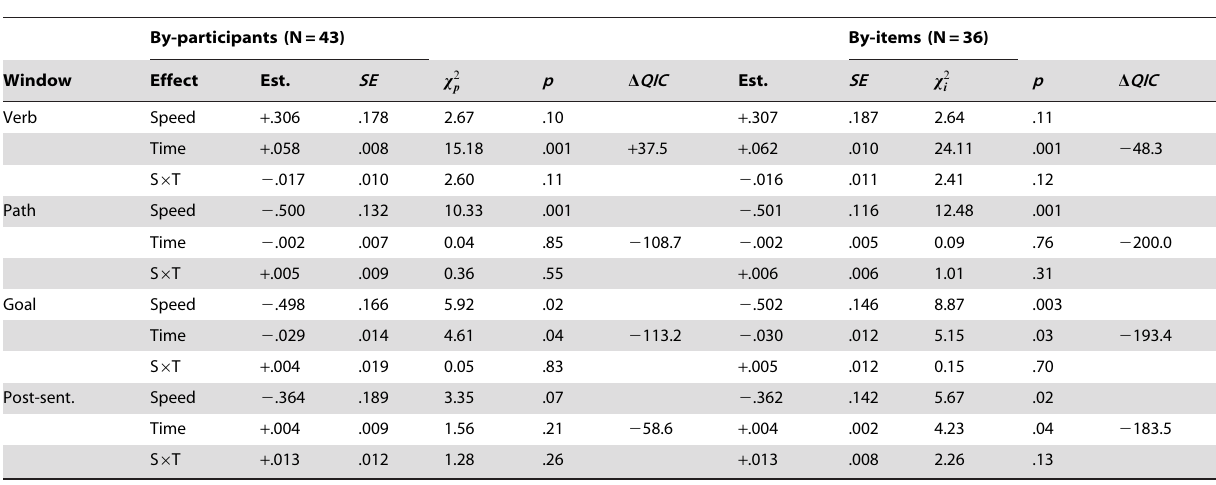
Table shows GEE modelling results for occurrences of looks to the Path ROI as a function of Verb Speed (fast vs. slow) and Time (continuous predictor referring to the 50 ms time-bins per window). Shown are the by-participant/by-item GEE parameter estimates and corresponding SE s (both in logit units) along with generalised score chi square statistics and related p -values (at df =1). As for interactions (S 6 T), a positive parameter estimate indicates a more positive slope for the Time predictor in the fast than in the slow Verb Speed condition. D QIC refers to the goodness of fit of the Verb Speed 6 Time model in relation to a competitor Agent-Verb Suitability 6 Lexical